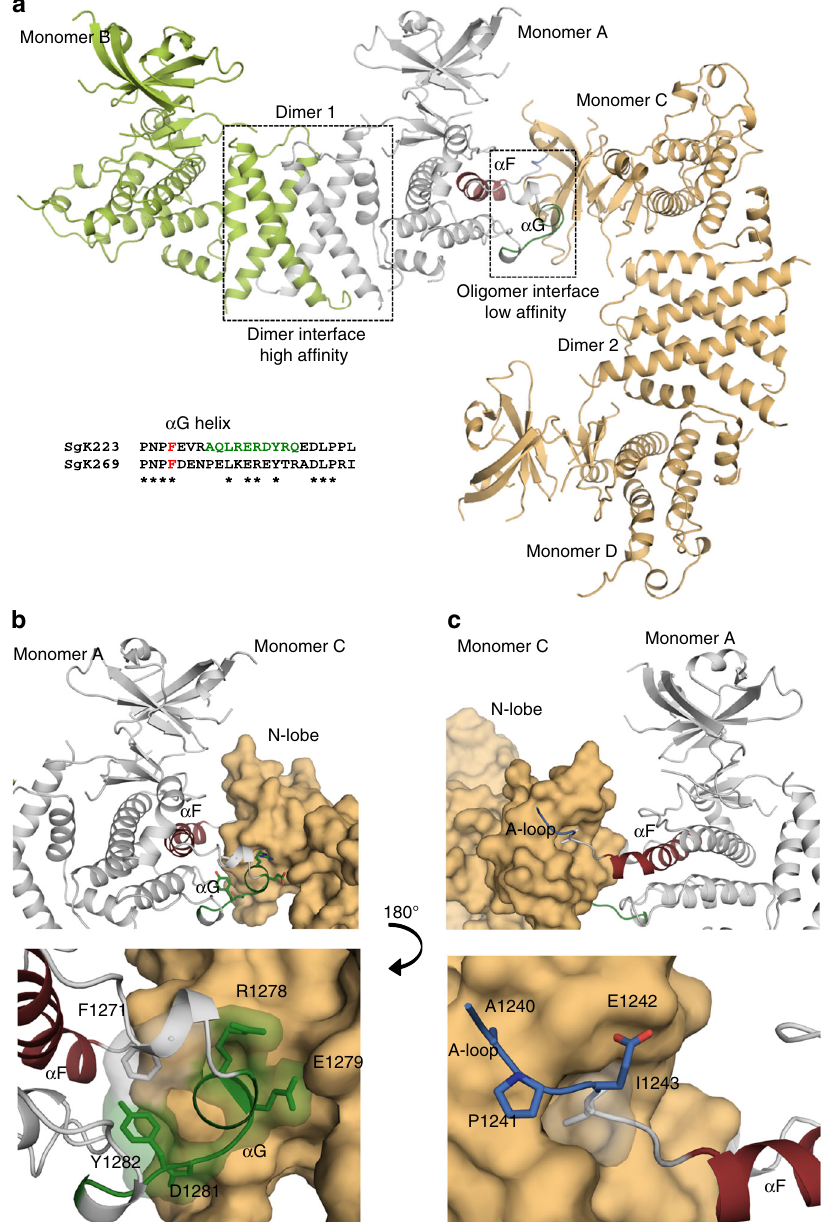
Fig. 5 SgK223 oligomerization. a Identi fi cation of the oligomer interface based on crystal packing between two dimers. b Oligomeric interaction made through α G helix (top) and close up of these interactions (bottom). c Oligomeric interaction made through the end of the activation loop (top) and close up of these interactions (bottom). Monomer B, lime green; Monomer A, grey; Monomer C and D, pale orange; α G, green; α F, brick red; A-loop, blue. See